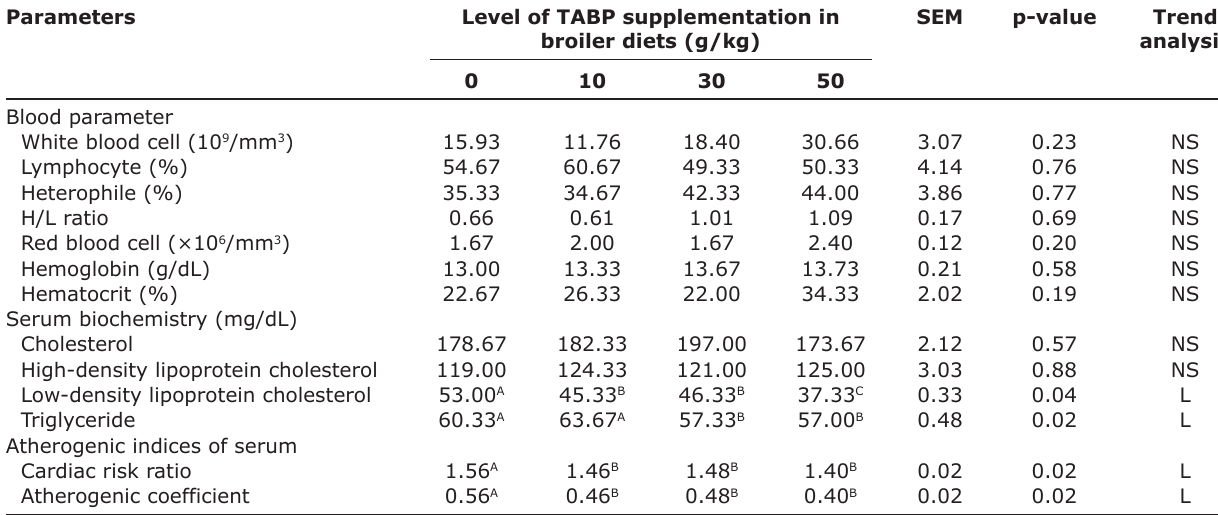
A,B Mean with symbol within same row differ significantly different (p<0.01), SEM=Standard error of mean, NS=Not significantly different (p>0.05),